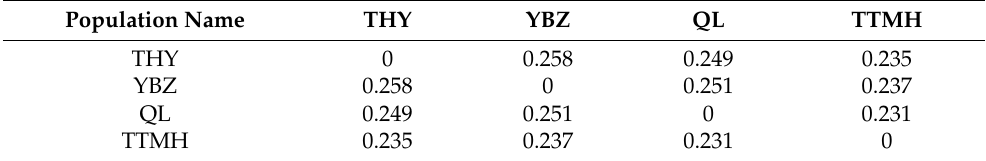
Table 3. Pairwise F ST among four populations of H. leucisculus .